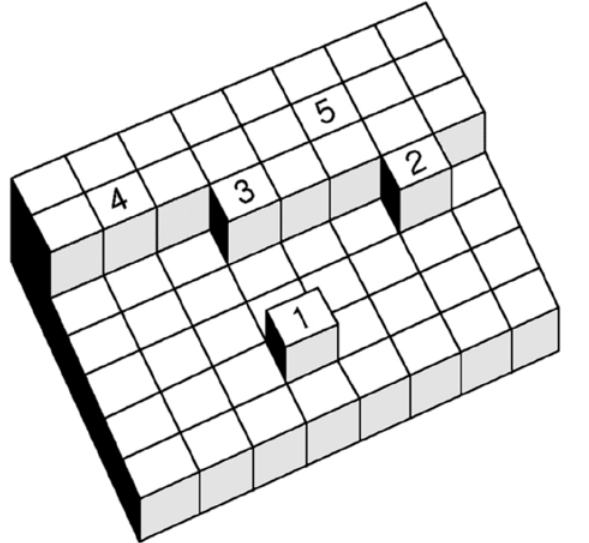
Figure 23. This is a diagram of a simplified square crystal lattice model. It shows the five possible types of surface exposure for the unit cells in such a lattice. The activation energies for each site dif- fers as the units are bonded to 1, 2, 3, 4, and 5 surfaces respectively. Sites 1 and 2 are most reactive and site 5 is least reactive. Since pre- cipitation or solution will occur preferentially at sites 1 and 2, the surface configuration tends to be continuously converted towards site 3 giving a ‘stepped’ growth to the crystal face.